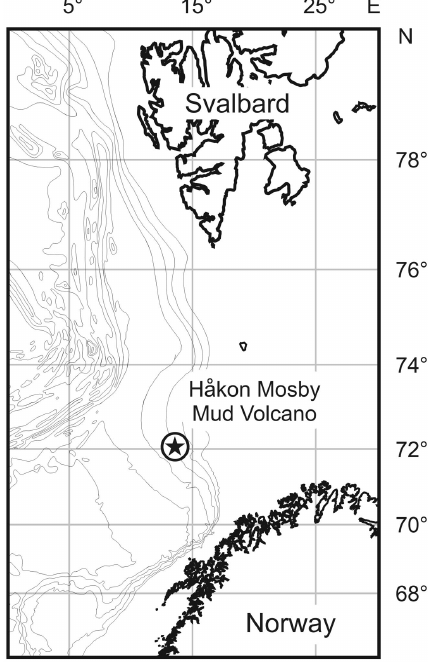
Fig. 1. Location of the H˚akon Mosby mud volcano in the south-west Barents Sea.